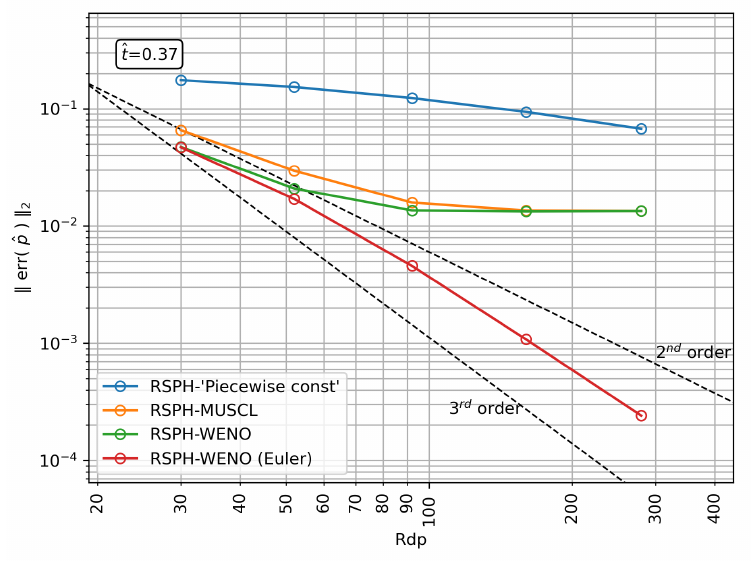
Figure 5. Convergence of the L2 norm of the 2D vortex pressure error at ˆ t = 0.37 (the resolution is expressed as the ratio between the domain radius and the particle spacing, Rdp) for five different RSPH